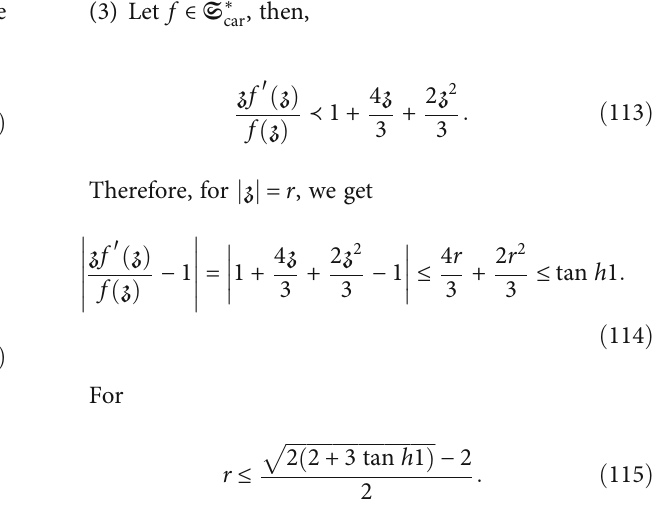
ffiffiffiffiffiffiffiffiffiffiffiffiffiffiffiffiffiffiffiffiffiffiffiffiffiffiffiffiffiffiffi 1 +